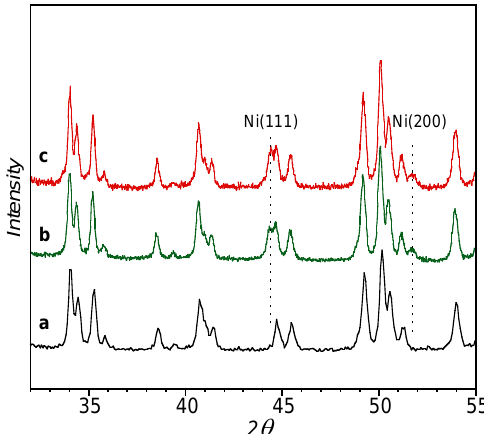
Figure 5. XRD patterns of monoclinic ZrO 2 and activated Ni/ZrO 2 catalysts. ( a ) Z m ; ( b ) 4.8Ni/Z hy ( red ); ( c ) 4.8Ni/Z hy ( ox-red ).